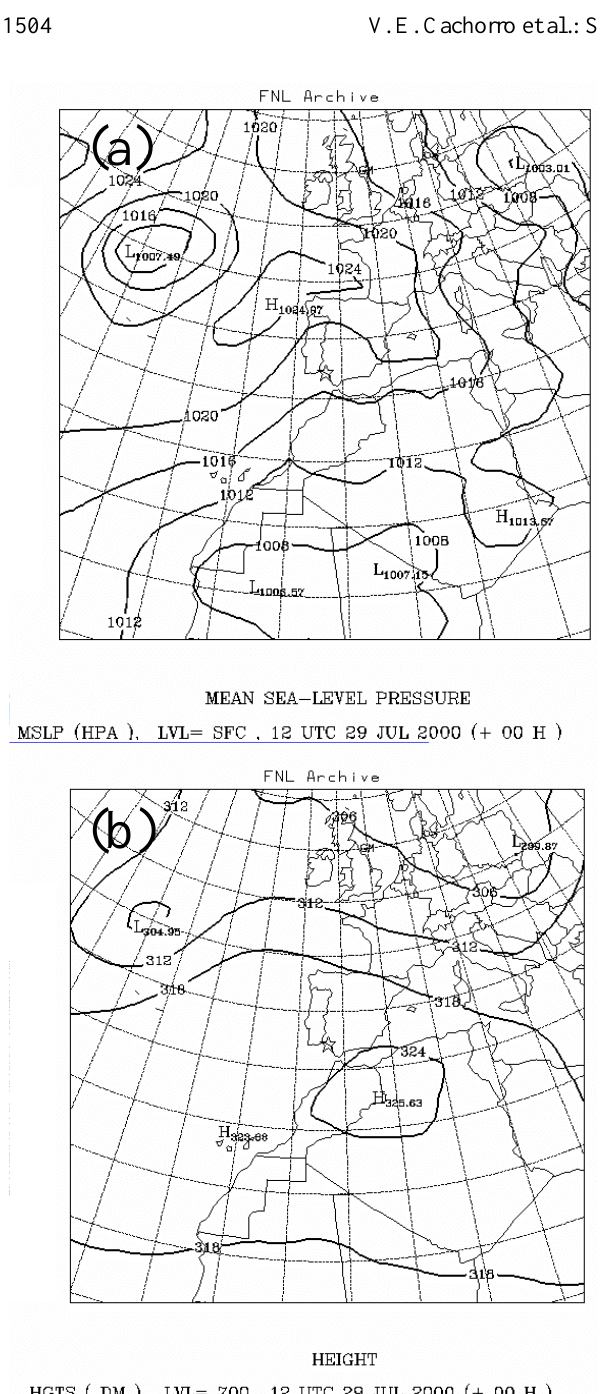
Fig. 8. Synoptic weather conditions in the study area on 29 July, given by the surface pressure, and 700mb maps generated by the NOAA FNL